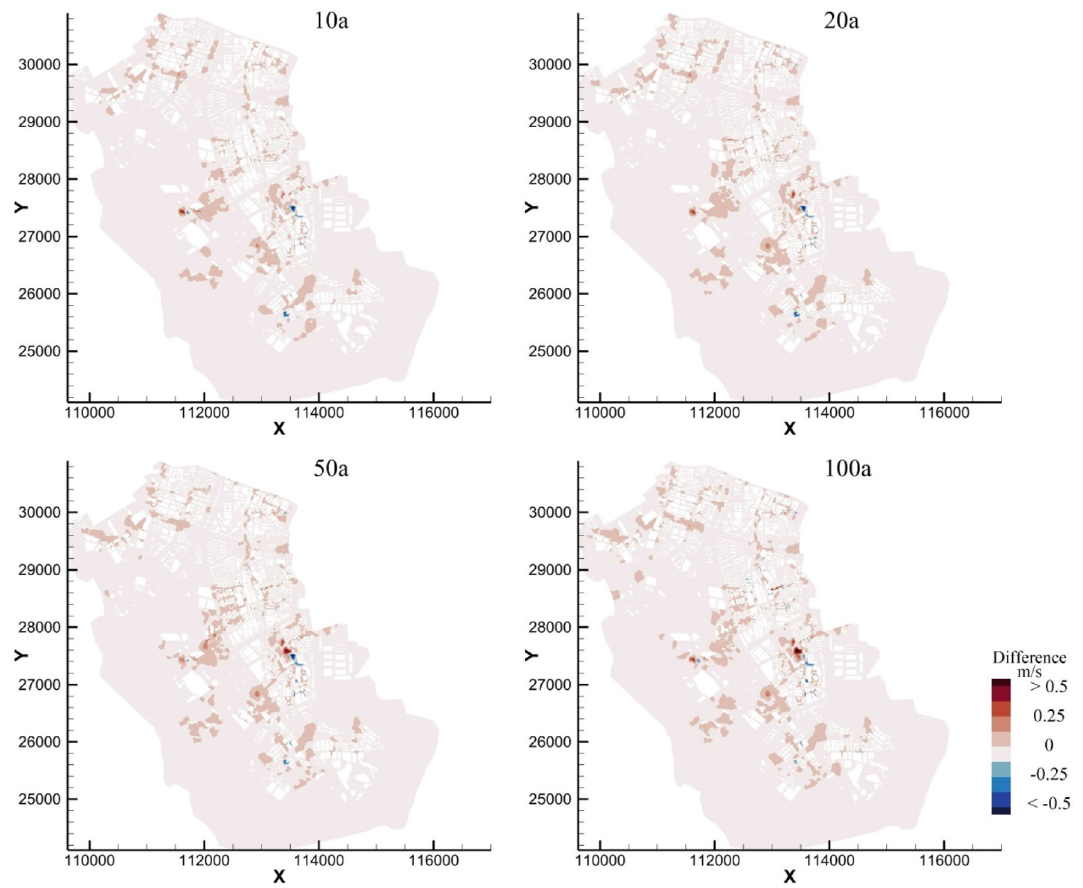
Fig. 14 Inter-comparison of the maximum flow velocity (obtained by the subtraction of the simplified urban stormwater model (SUSM) results from the urban stormwater model (USM)